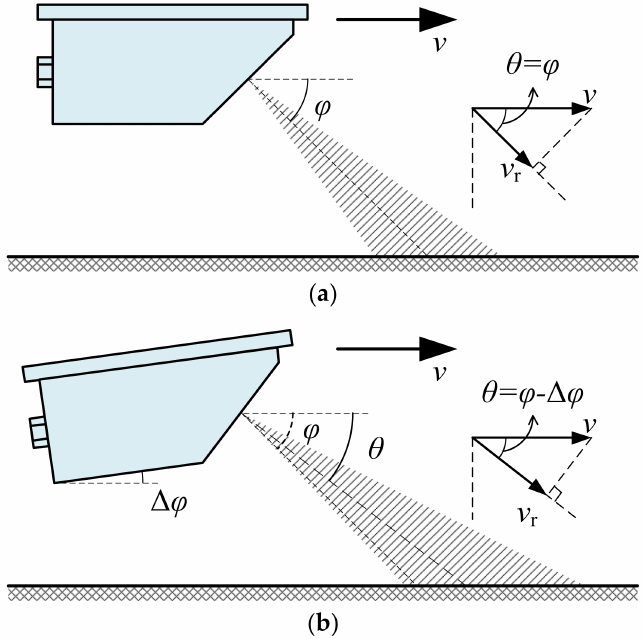
Figure 2. The simplified schematic diagram of the working principle of the SDRS: ( a ) the ideal situation without installation deviation; ( b ) the actual situation with installation